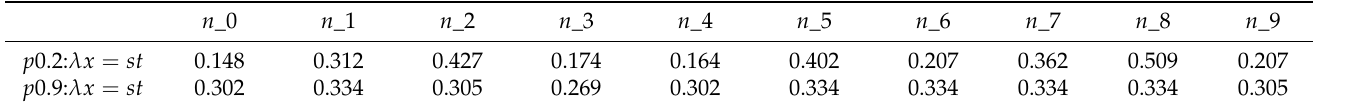
Table 9. Calculated social ties (𝑠𝑡) from 𝜆𝑥 = 𝑠𝑡 ∈ (0,1) of a random graph.